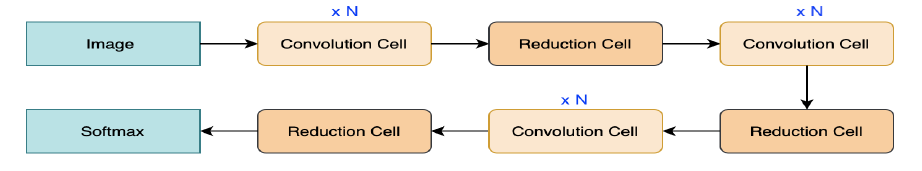
Figure 5. Illustration of a deep neural network generated by ENAS that contains 3 blocks, each with N optimal convolution cells and one reduction